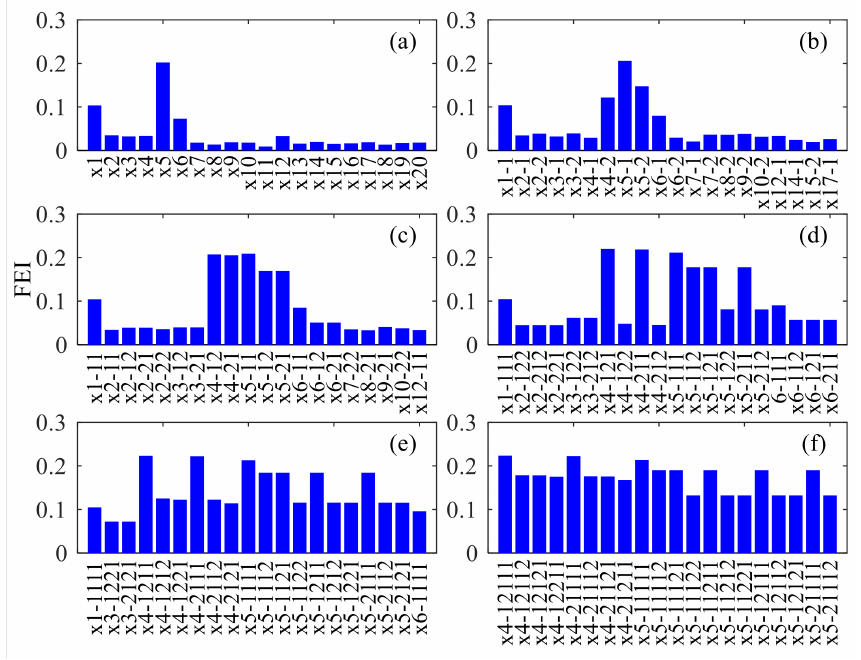
Figure 9. Improved SVD denoising method process: ( a ) pre-decomposition, ( b ) 1st MRSVD, ( c ) 2nd